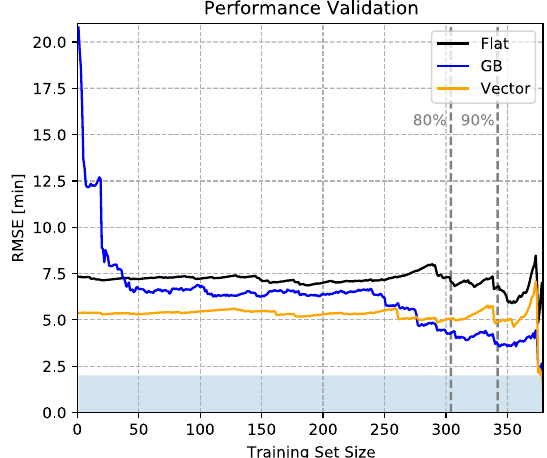
Fig. 7. Comparison of model performance (RMSE) with varying train/test set ratios for the gradient boosting (blue) model. Physical models, vector delay (orange) and fl at delay (black) are evaluated on the same test set size which is equal to 380 – training set size. The shaded region corresponds to the estimated error in the delay